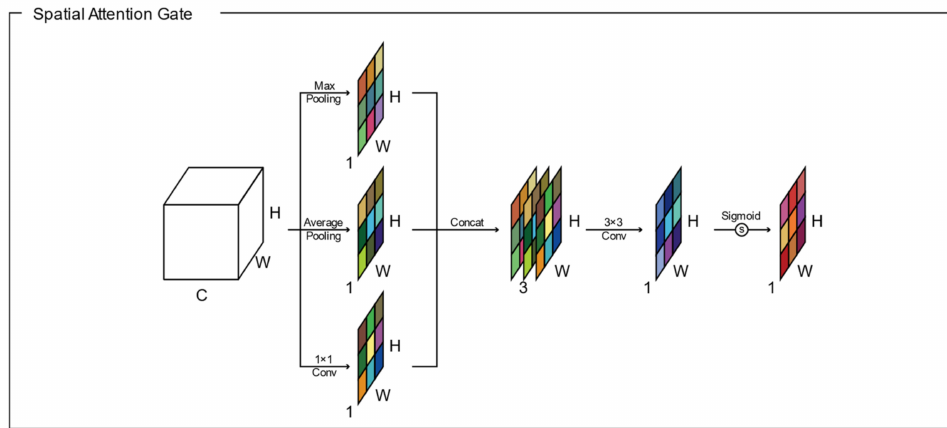
Figure 3. Spatial attention gate.